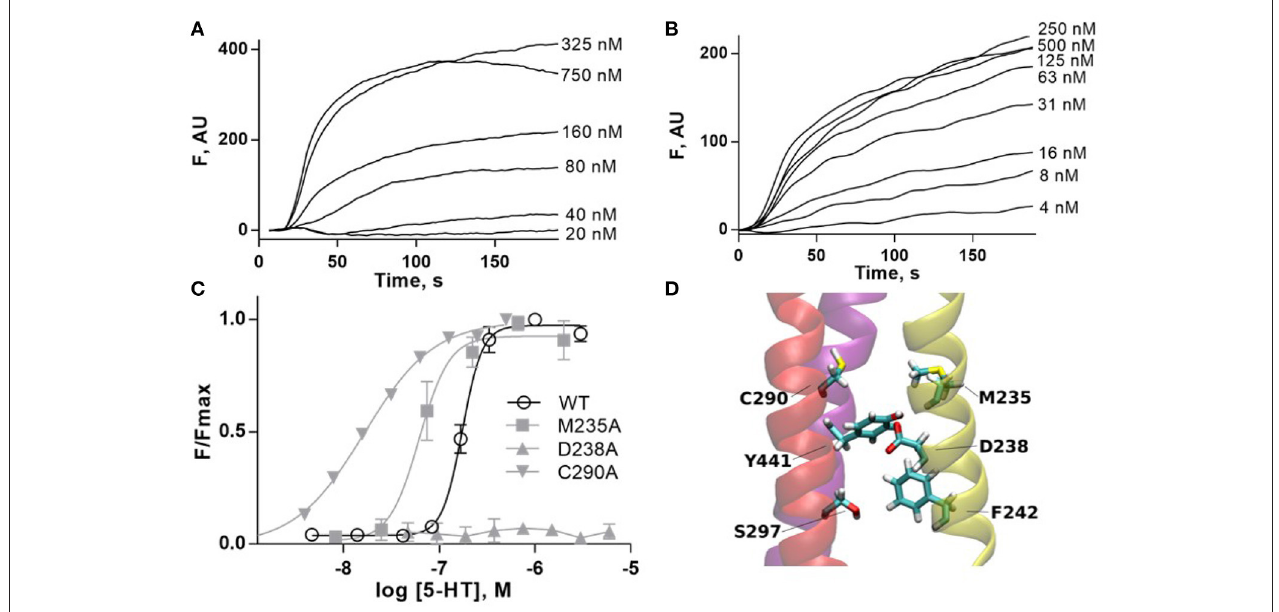
FIGURE 6 | (A,B) Typical fluorescent responses (F in arbitrary units, AU) to addition of 5-HT at 20 s to HEK293 cells expressing 5-HT 3A receptors, using a membrane potential sensitive dye. (A) WT, (B) C290A. (C) 5-HT concentration-response curves of mutant receptors in HEK293 cells. For D238A F is compared to WT Fmax. Data is mean ± standard error of the mean (SEM), n ≥ 3. (D) Molecular dynamics snapshot showing Y441 in the M4 helix together with possible interaction partners. M1: yellow, M3: red, M4: purple.